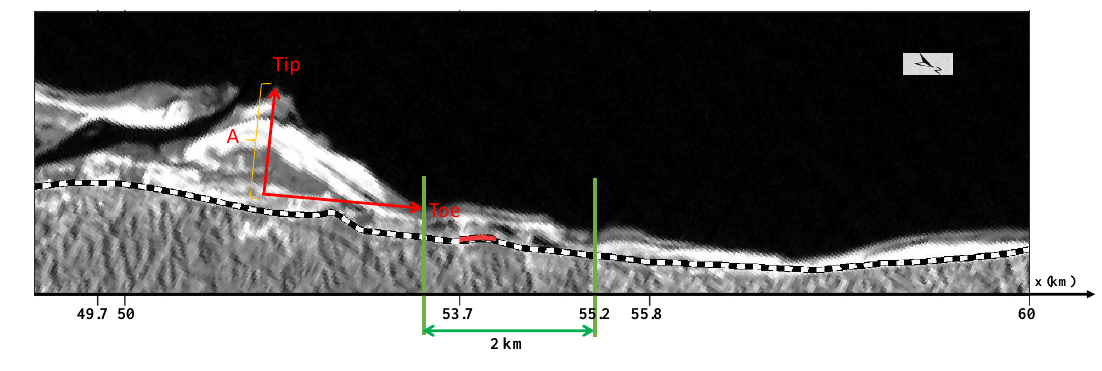
Figure 16. Definition of sand spit amplitude, A.